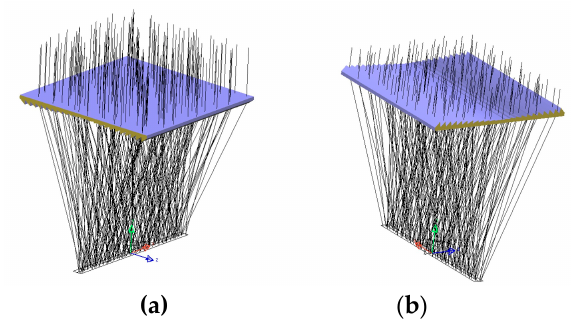
Figure 11. The ray tracing of sunlight convergence on one dimension onto the focal line using the linear Fresnel lens with ( a ) the lower groove surface and ( b ) the upper groove surface.